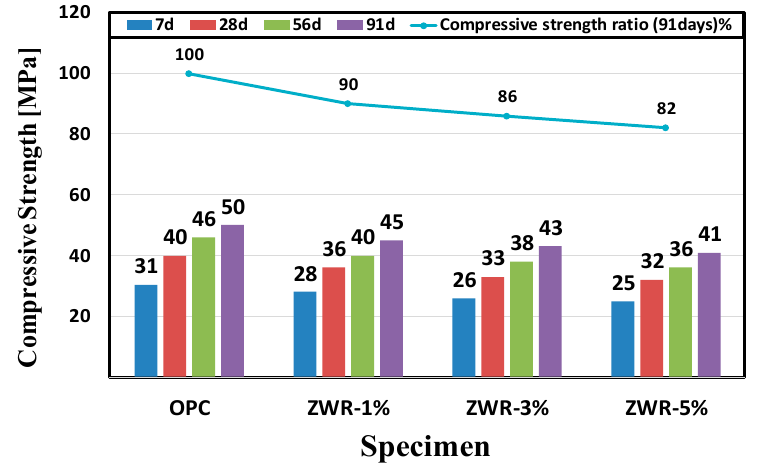
Figure 10. Graph of compressive strength test.